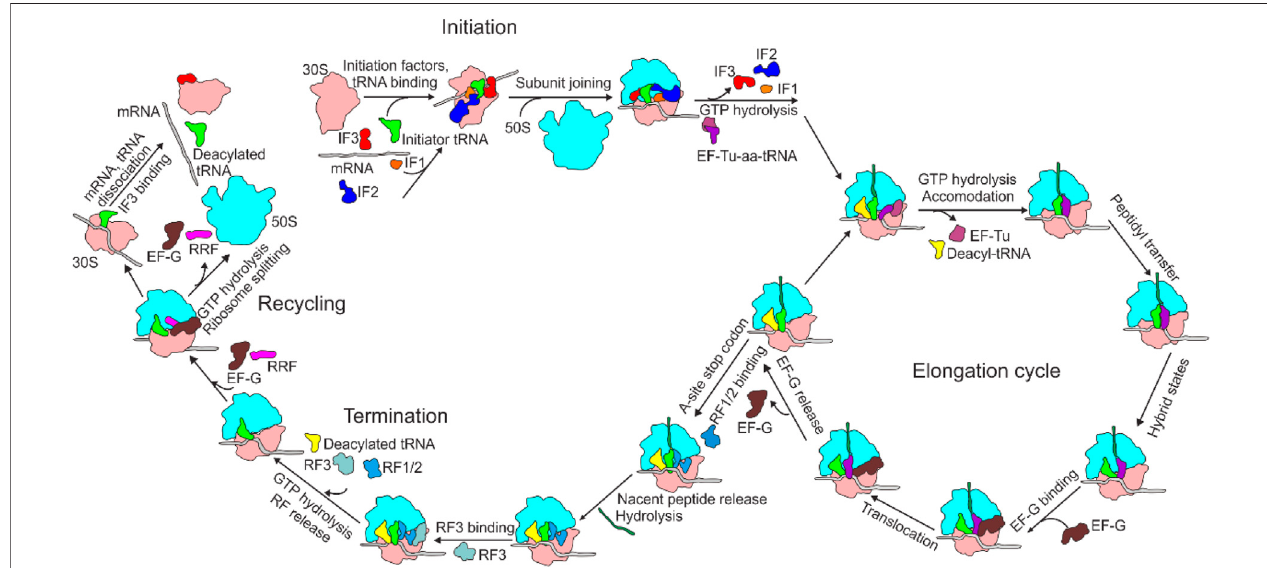
FIGURE1| Overviewofbacterialtranslationcycle.aa-tRNA,aminoacyl-tRNA;EF,elongationfactor;IF,initiationfactor;RF,releasefactor;RRF,ribosomerecycling factor.